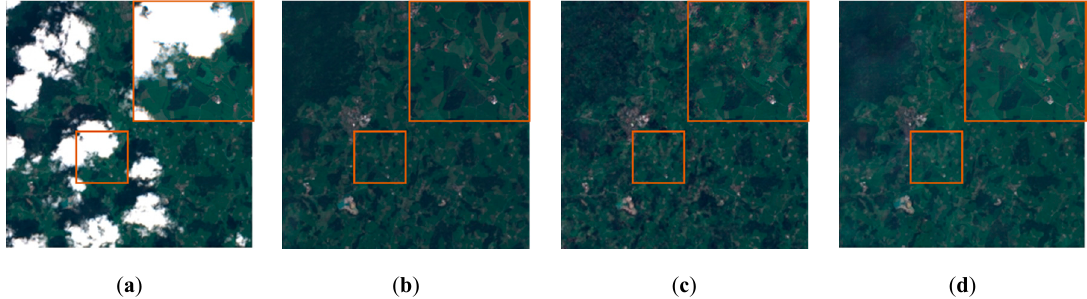
Figure 8. Results of Area 2 in the real experiment. ( a ) Ground truth of the optical image. ( b ) Pix2pix. ( c ) SAR-opt-GAN. ( d ) The proposed method.